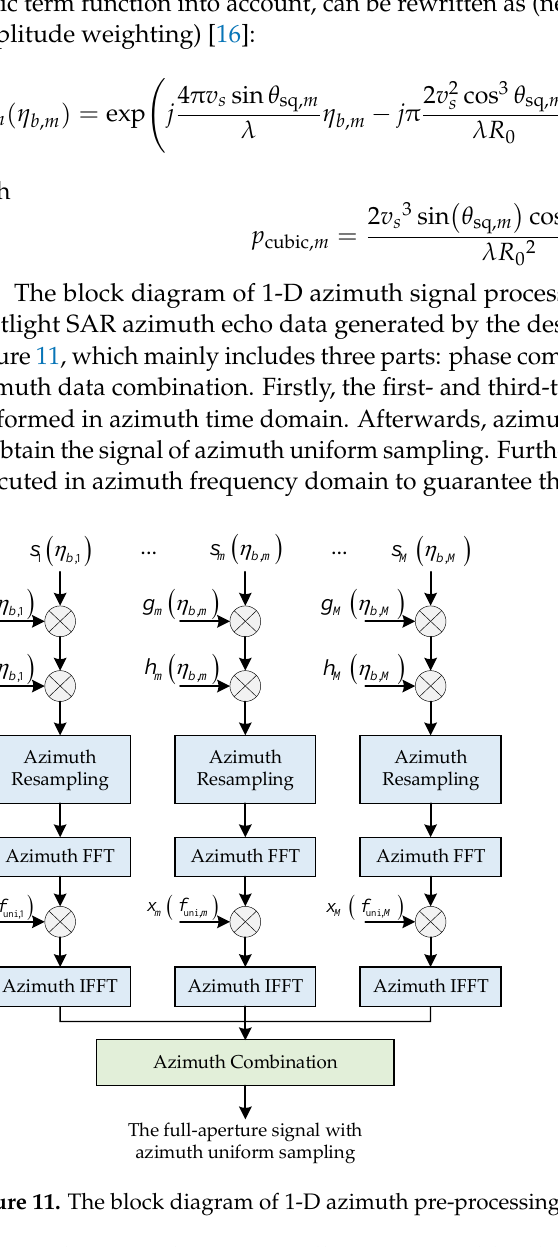
Figure 10. For the prior data block with the central squint angle of 27.3 ◦ , when the pulse bandwidth is 150 MHz, the total Doppler bandwidth is 7176 Hz, which is greater than the operated PRF. For the latter data block with the central squint angle of 25.3 ◦ , when the pulse bandwidth is 150 MHz, the total Doppler bandwidth is 7225 Hz and is also greater than the PRF. Therefore, the Doppler spectrum aliasing of each block data caused by the squint angle and azimuth beam steering must be eliminated before azimuth combination.